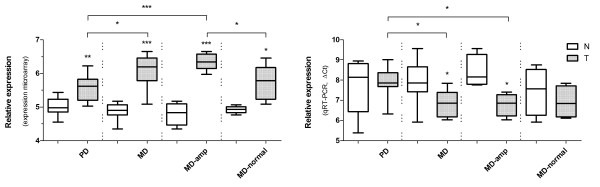
The mRNA level ofC20orf11in normal gastric tissues (N) and gastric cancer tissues (T). Relative expression was from expression microarray and qRT-PCR. Data were presented as Box and Whisker plots with *P < 0.05, **P < 0.01, and ***P < 0.001. ΔCt-values denoted up-regulated expression in T as compared with N. MD-amp, the MD gastric cancer samples with amplification at C20orf11; MD-normal, the MD gastric cancer samples without CNVs at C20orf11.